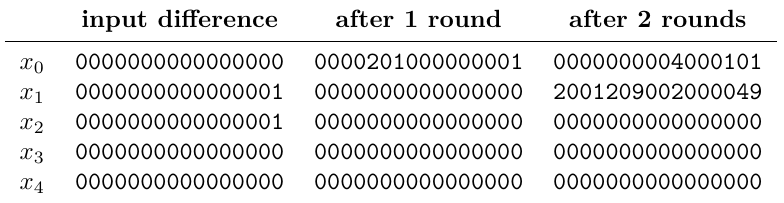
Table 13: 3-round differential characteristic for 5-round non-black-box limited-birthday distinguisher (4 round on black-box) on the Ascon permutation. The differential probabil- ity is 2 − 40 . The breakdown of the probability (in − log the start of round 3, we can achieve the distinguisher with a complexity of 2 2 permutation calls.